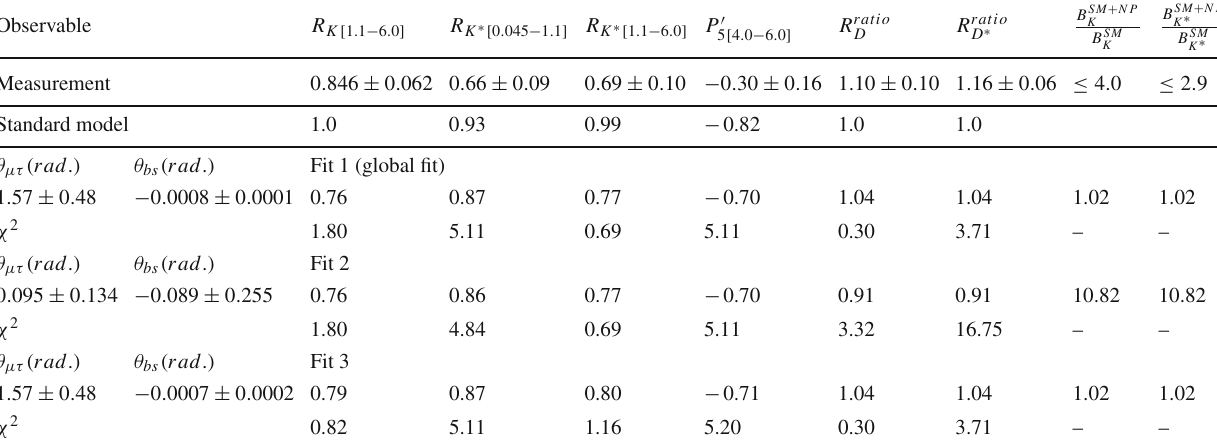
Table 3 Best fit values of the mixing angles in S 3 leptoquark model. For Fit 1, dof=122, χ 2 / dof = 1 . 02 Observable